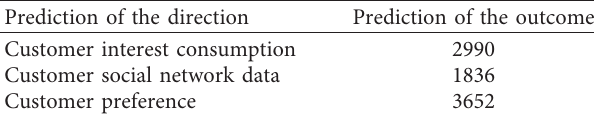
Table 1: Customer consumption behavior forecast table. Prediction of the